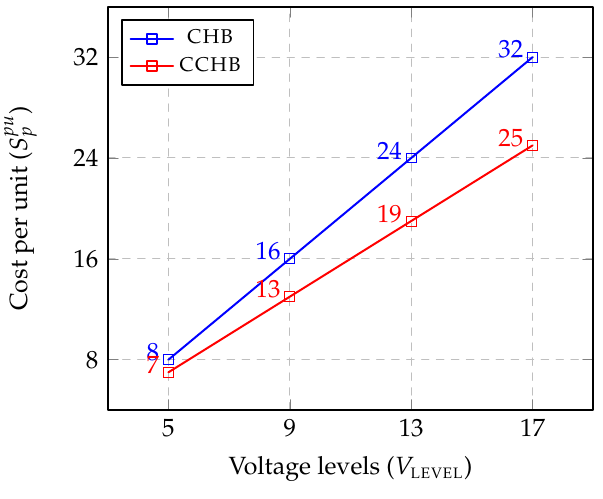
Figure 11. Switches costs per unit of proposed CCHB with CHB